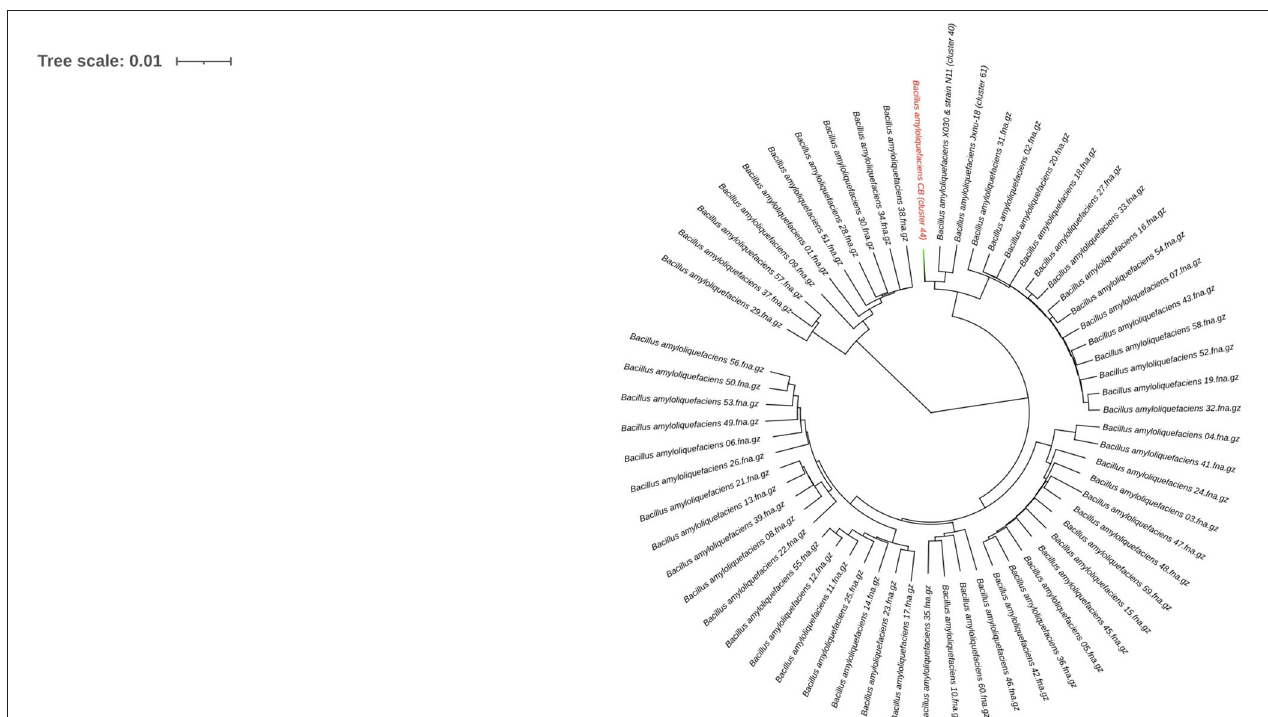
FIGURE 1 | Genome lineage tree of Bacillus amyloliquefaciens strain CB. BIONJ algorithm was used to construct the Newick format tree from the distance matrix of all the clustered assemblies (119 different strains of B. amyloliquefaciens ). The generated Newick tree file was analyzed using the Interactive Tree Of Life (iTOL) v. 5 (strain CB highlighted in red color text with light green color branch).